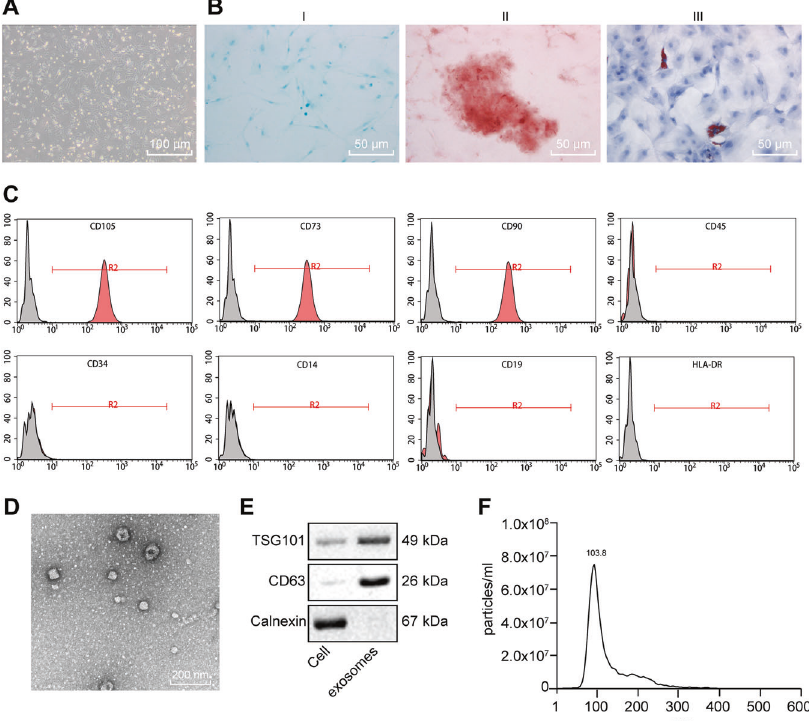
Fig. 1 Identi fi cation of MSCs and exosomes. A Morphologic characteristics of MSCs at the fi fth in culture were observed under an inverted microscope (×100). B Chondrocyte formation, osteoblast formation, and adipogenic differentiation were analyzed by cytochemical staining of Alcian blue (I, ×200), Alizarin Red, (II, ×200) and oil red O (III, ×200). C Expression of the surface marker proteins associated with MSCs was determined by fl ow cytometry. D Ultrastructure of exosomes was observed under a transmission electron microscope (×5000). E Representative western blots of the surface marker TSG101 and CD63 proteins. F Concentration and size of exosomes were detected by NTA analysis.